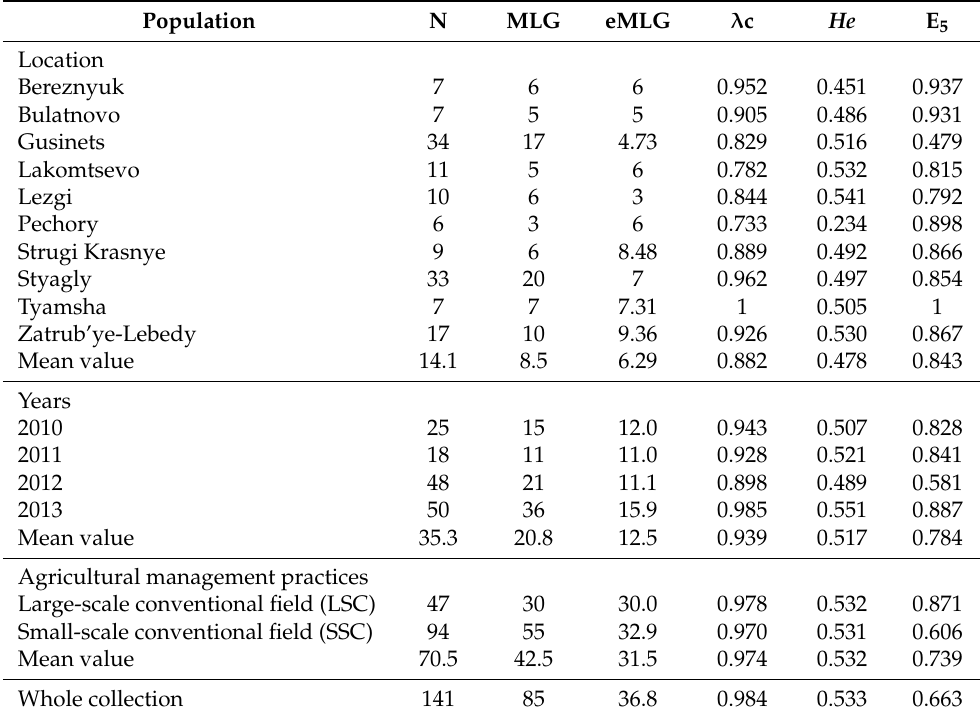
Table 4. Summary of the P. infestans’ population diversity indices averaged over 12